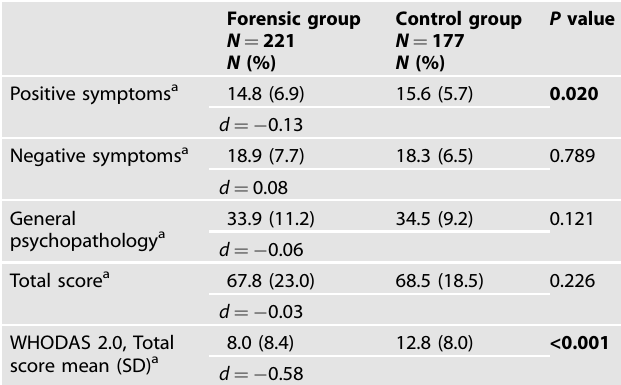
Given the results of the correlational analyses, logistic regres- sion models were performed to investigate whether BACS scores affected the relationship between SC and groups (Supplementary Table 4S). The results of this analysis show that performance on the BACS accounts for the majority of the relationship between SET and the two groups. In addition, it has an effect on the relationship between the groups and ER Accuracy for Fear, ER Accuracy for Sadness and ER Accuracy for Contempt. Based on these results, all variables that were signi fi cantly different between the two groups, adjusted for education and gender (see Table 2), were analysed using PLS-DA, together with regression models — see Supplementary Table 4S). The outcome of this analysis is shown in the loading plot of Fig. 2, wherein the longer the bar, the higher the loading. Thus, through this analysis is possible to obtain a ranking of those variables which best discriminated between the two groups. Moreover, the colour of each variable bar indicates the group for which the mean value is higher. It can be noticed that education and BACS Symbol coding are the strongest discriminators of forensic and non-forensic patients, followed by ER scores. In particular, among ER scores, accuracy on anger recognition was the ER variable with highest loading.